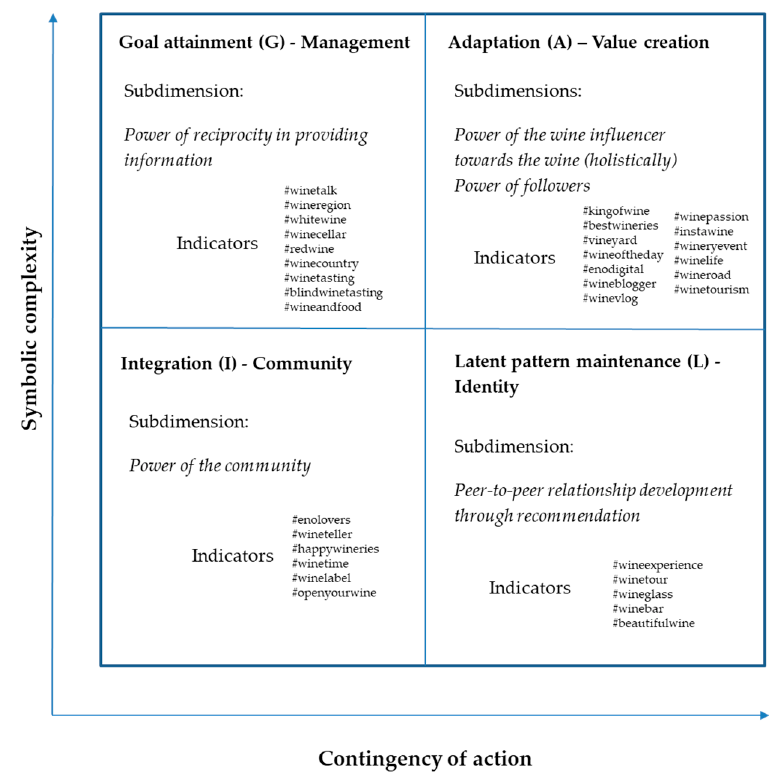
Figure 3. Authors’ presentation of the AGIL scheme with dimensions and sub-dimensions of the Wine Influencer ‘s Communication Model in Instagram.